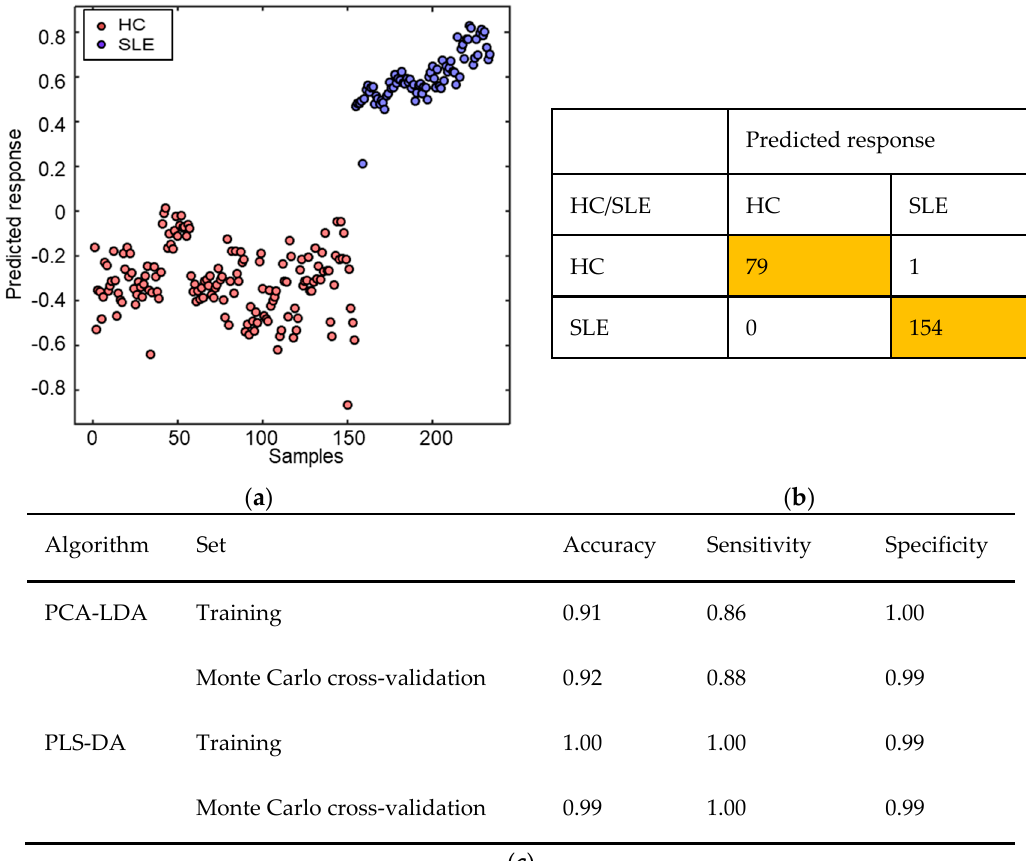
Figure 3. PCA-LDA and PLS-DA results for classification of SLE patients and HC using Raman serum analysis. ( a ) PLS-DA classification model predicted response for SLE patients (red circles represent 154 individual spectra for 8 patients) and HC (blue circles represent individual spectra for 4 participants). ( b ) Cross-validation confusion table generated from individual spectra, 154 SLE spectra ( n = 8 patients) and 80 HC spectra ( n = 4 participants). ( c ) Classification model performance characteristics. Note: PCA-LDA model built with 10 PCs, and PLS-DA model built with 6 LVs. Cross-validation: Monte Carlo leaving 20% of samples out with 1000 interactions. Pre-processing: rubber band baseline correction and vector normalisation.